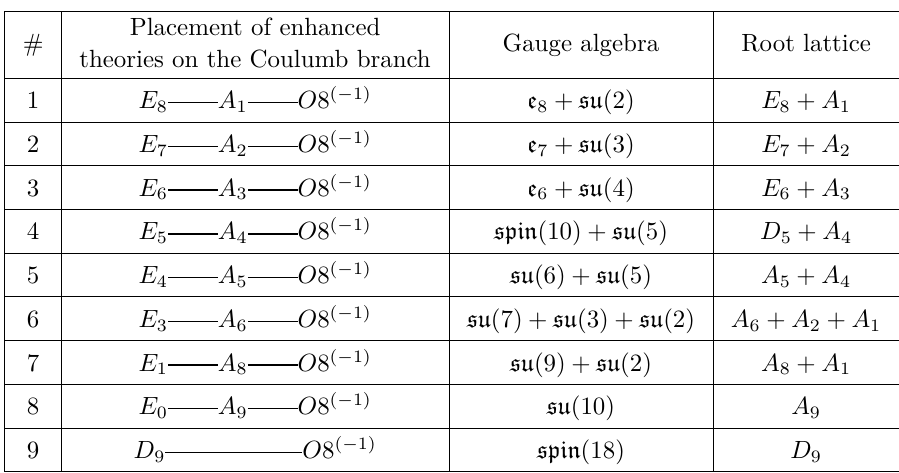
Table 3 . List of possible maximally enhanced rank 9 theories in nine dimensions which is obtained by Swampland considerations. The above table matches with table 3 in [50] which have string theory realizations.